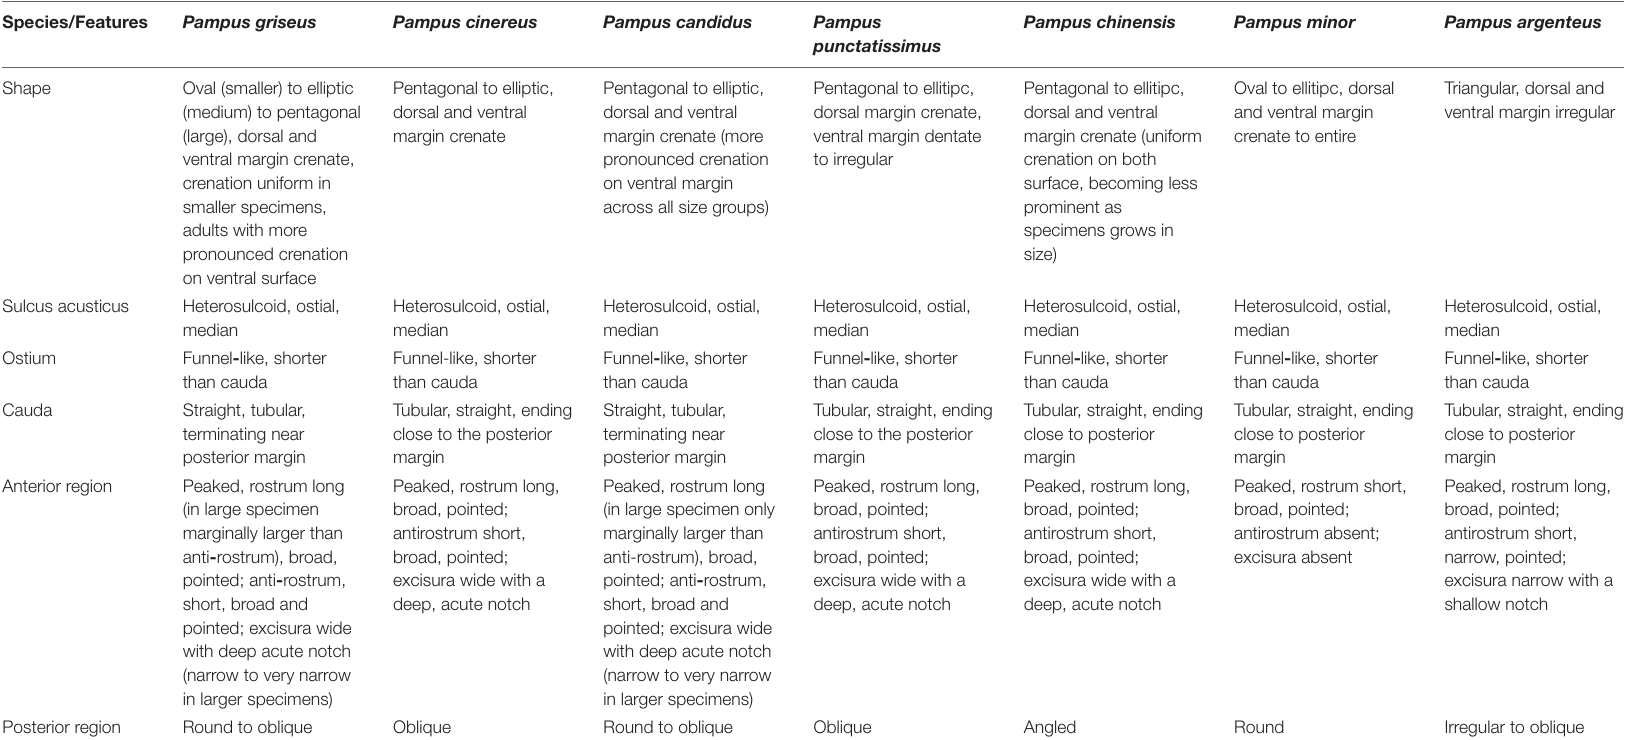
The shape, crenulation, rostrum, excisura, and ventral margin show a pattern in progression from juveniles to adults and, hence, can be used with caution in differentiating and describing the species solely based on otolith